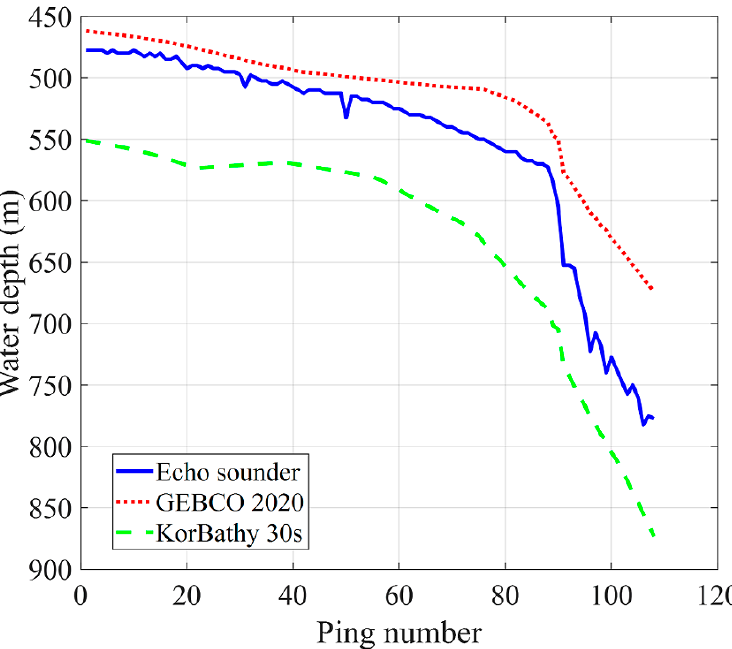
Figure 17. Water depth estimated by the echo sounder data (solid line), the GEBCO 2020 (dotted line), and the KorBathy 30s (dashed line) at the ship position of ping number.